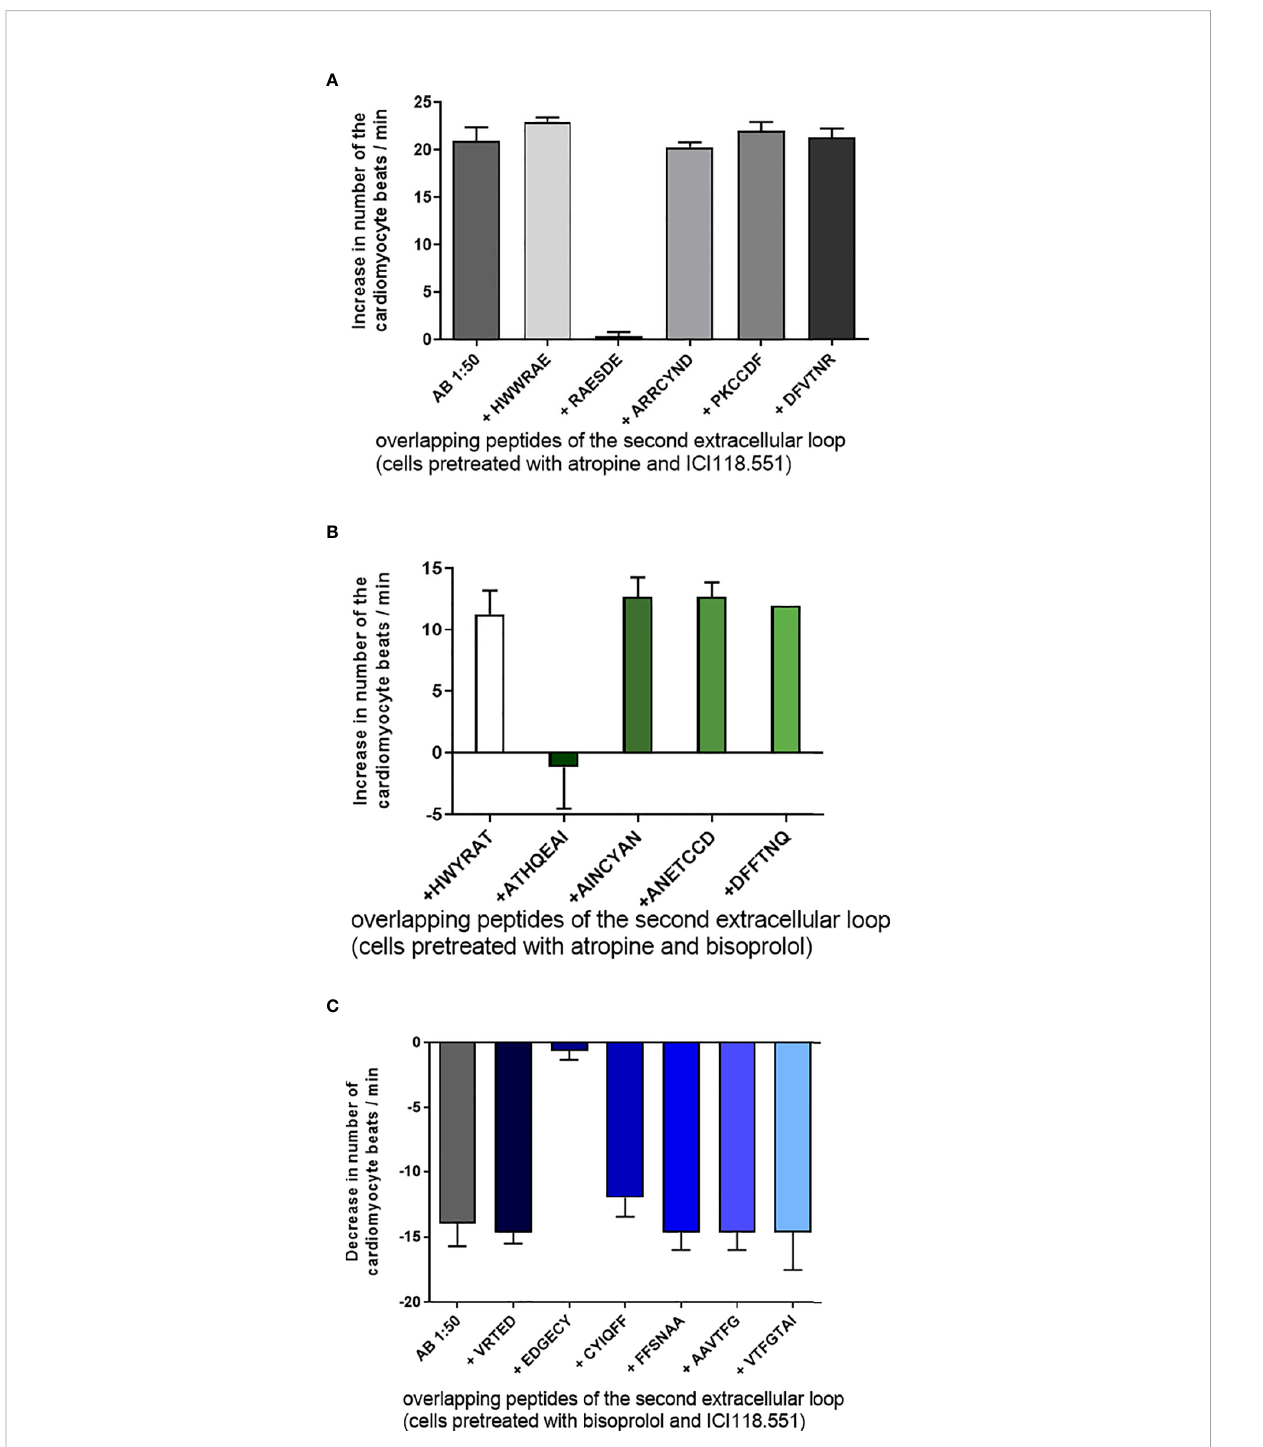
FIGURE 3 Tagging of the binding epitopes of the antibodies (Abs) on the extracellular structures of the receptors. (A) The binding site of the b 1- adrenoceptor Abs on the second extracellular loop of receptor represented by the peptide RAESDE. The b 2-adrenoceptor Abs recognize the peptide sequence ATHQEAI on the second extracellular loop (B) and the muscarinic M2 receptor Abs recognize the sequence EDGECY localized on the second extracellular loop of the M2 receptor (C) . The other short overlapping peptides of the three receptors did not develop any neutralizing activity. Cells were pre-treated with bisoprolol, a speci fi c b 1- receptor antagonist, ICI118551, a speci fi c b 2- receptor antagonist and atropine, a muscarinic M2 receptor